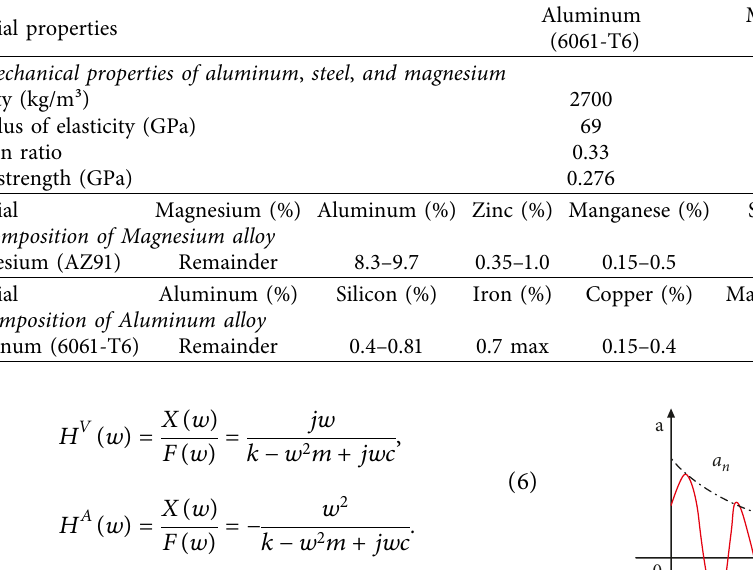
Table 1: Properties of aluminum, steel, and magnesium.